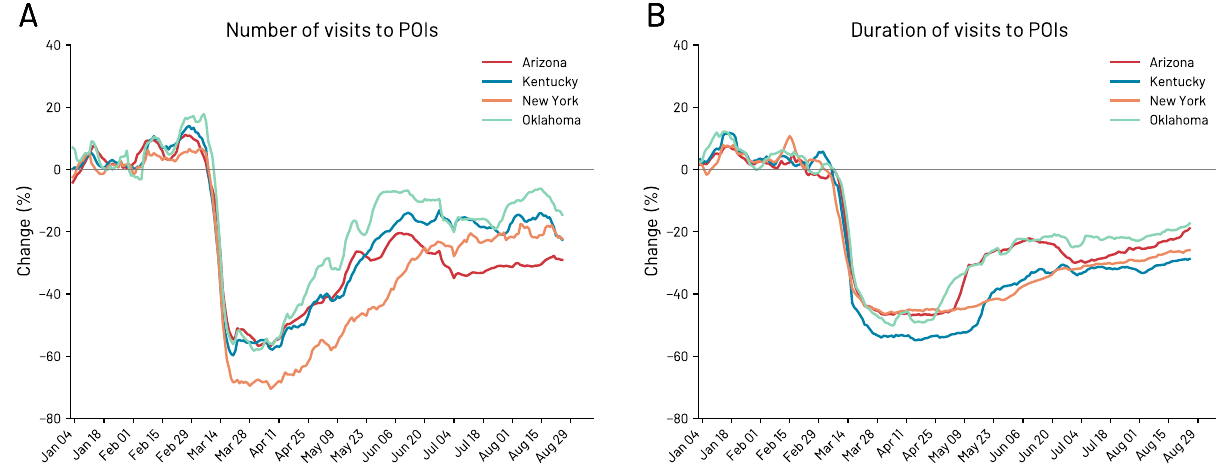
Figure 2. Changes in number and duration of visits to all POIs in the states of Arizona, Kentucky, New York and Oklahoma. ( A ) Percentage change over time in the number of visits with respect to the baseline period (3 January 2020–28 February 2020) for all types of venues. ( B ) Change in percentage of the duration of visits over time with respect to the baseline period of the median duration of visits to all POIs. For visualization purposes, the original curves are smoothed using a rolling average of seven